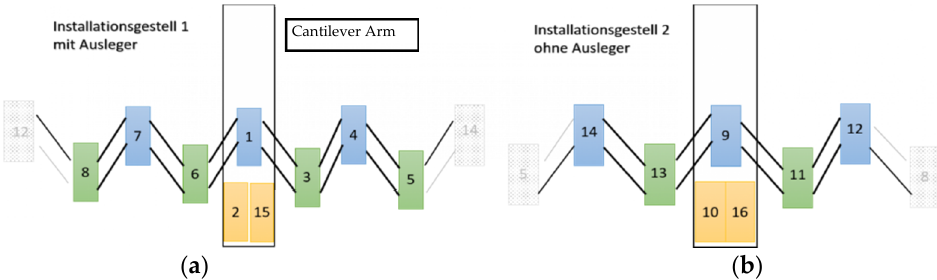
Figure 11. System overview: Installation Rack 1 ( a ); Installation Rack 2 ( b ).